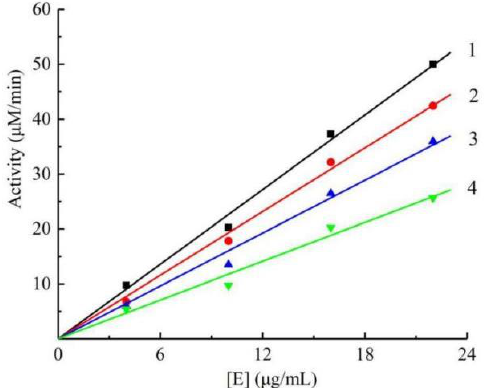
Figure 2. Remaining mushroom tyrosinase activity at different concentrations of Q1. Concentrations of Q1 for curves 1 – 4 were 0, 15, 60, 120 µM. Different concentrations of the compound Q1 (0, 15, 60, and 120 μM) were applied to inhibit tyrosinase and obtain the kinetic behavior of tyrosinase catalysis. Lineweaver – Burk reciprocal plots were used to investigate the inhibition modes of Q1 on mushroom tyrosinase. As shown in Figure 3, a series of lines with various intercepts and slopes met in the second quadrant, revealing Q1 inhibited enzyme activity adopting a mixed inhibi- tion type. Thus, Q1 could bind not only to the free enzymes but also to the enzyme – sub- strate complexes. In addition, we obtained the inhibitor constant (K I ) through the concen- trations of the compound versus the plots of the slope, and the value of K I was determined to be 117.07 μM. Additionally, the value of K IS was measured to be 4 23.63 μM from the concentrations of the compound versus the vertical intercept. The value of K IS was higher than K I , revealing that Q1 has a stronger affinity for the free enzyme than the enzyme – substrate complex. Figure 3. Kinetic parameters of mushroom tyrosinase inhibition by Q1. Concentrations of Q1 for curves 1 – 4 were 0, 15, 60, 120 µM. 2.4. Fluorescence Analysis 2.4.1. Fluorescence Emission Spectra of Mushroom Tyrosinase in the Presence of Q1 with Various Concentrations The intrinsic interaction mechanisms of Q1 on the tyrosinase were investigated by the fluorescence quenching analysis. The fluorescence emission spectrum was recorded as ranging from 310 to 550 nm at a 290 nm excitation wavelength. As shown in Figure 4, tyrosinase had a strong fluorescence peak at 333 nm because of fluorophore tryptophan residue, while Q1 displayed an emission peak at 411 nm. However, the fluorescence in- tensity of tyrosinase reduced gradually as the concentration of the citral derivative in- creased . When Q1 was added to 36 μM, the relative fluorescence intensity of tyrosinase